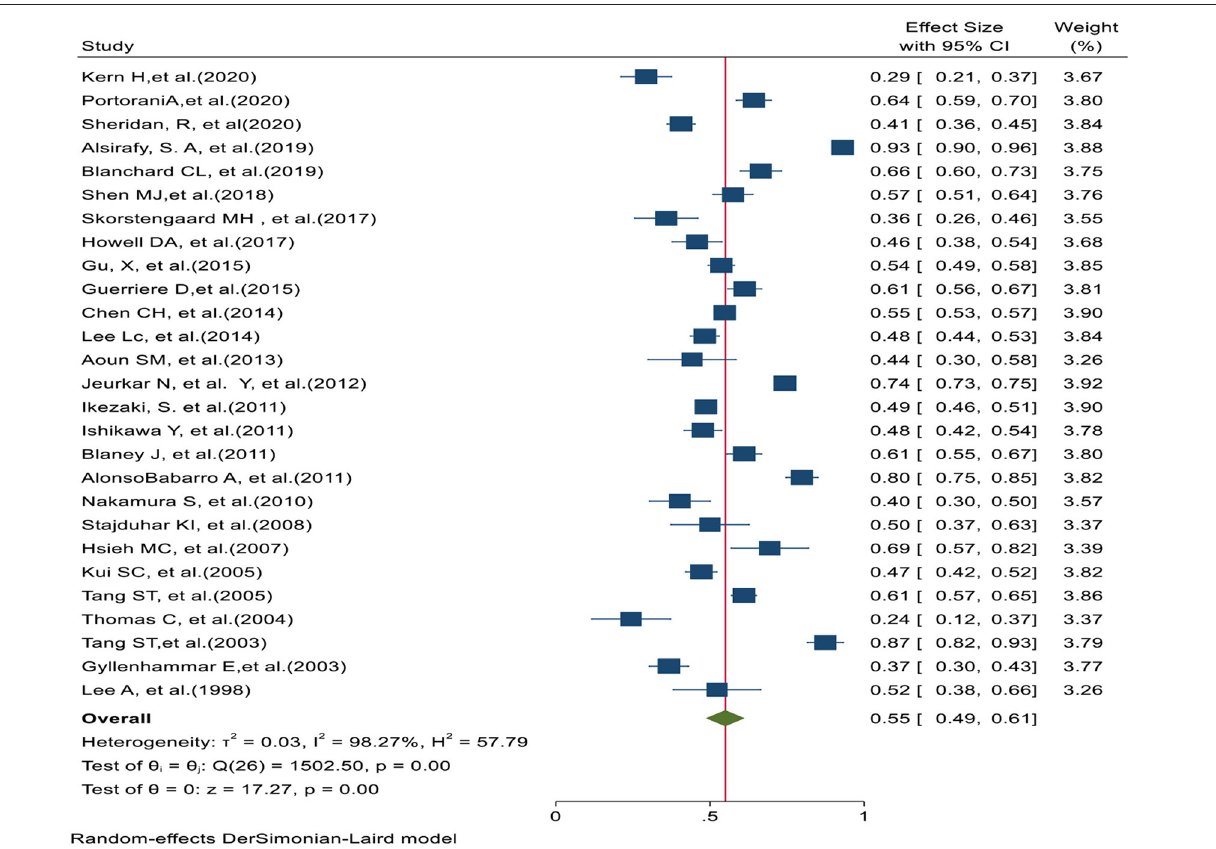
a significant related to the choice of preferred place of death in patients with